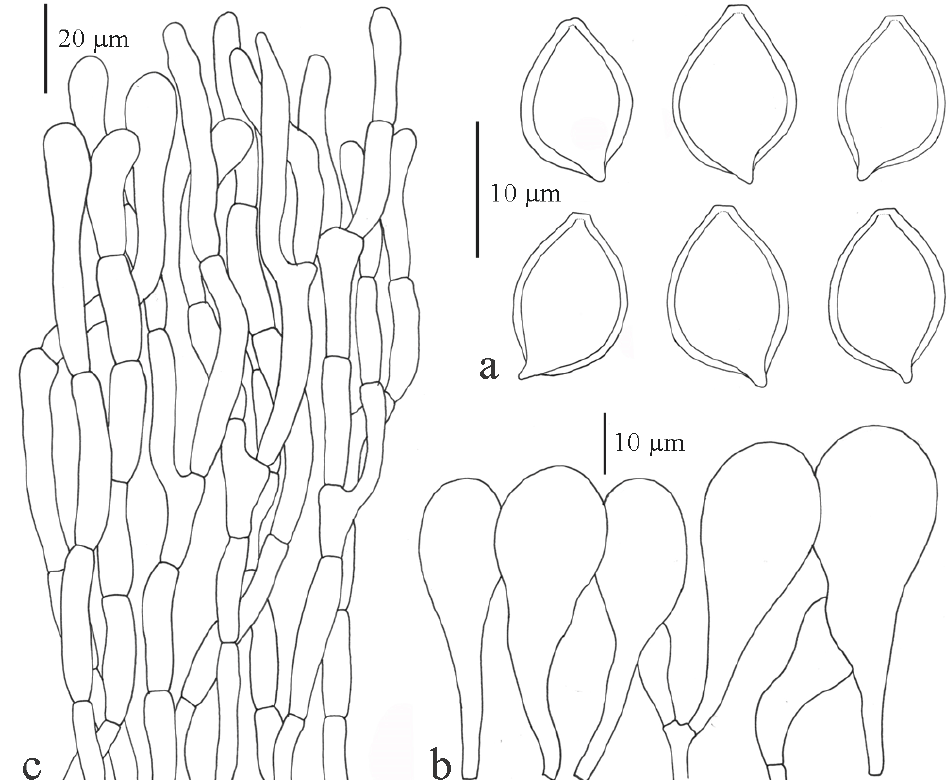
Figure 8. Chlorophyllum globosum (MFLU 12-1815). ( a ) Basidiomata. ( b ) Basidiospores. ( c ) Pileus covering elements.